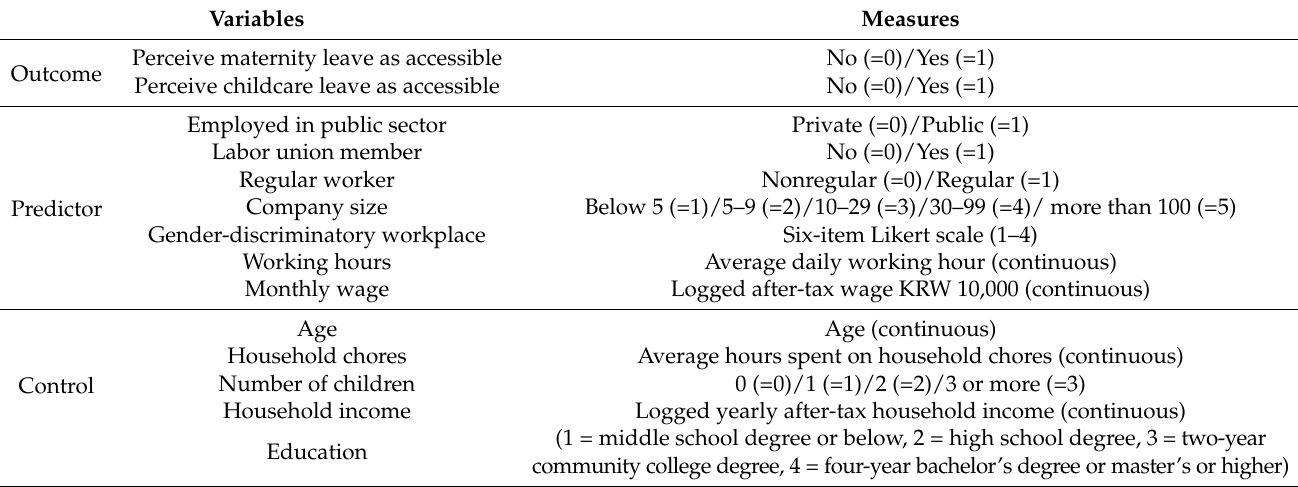
Table 1. Summary of the